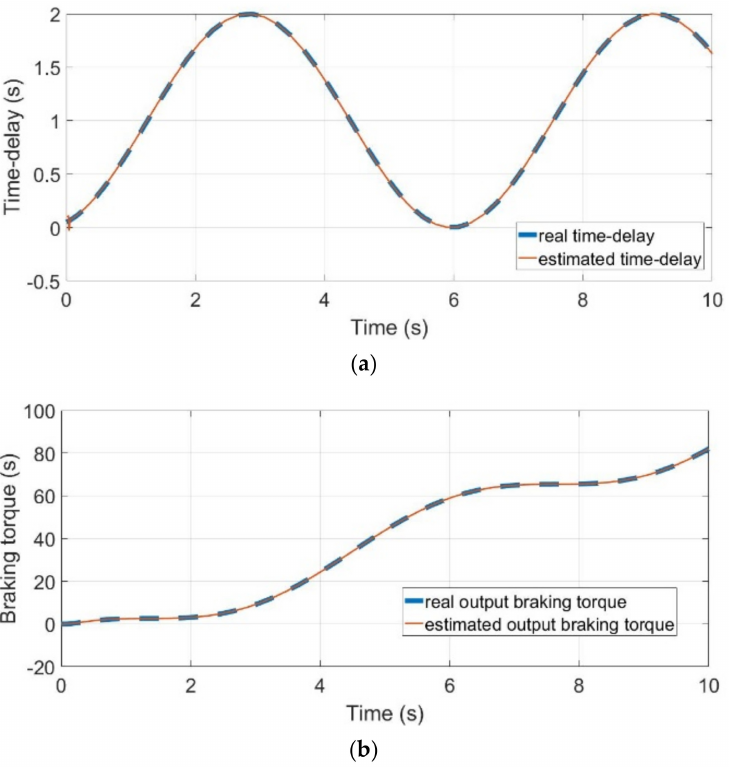
Figure 8. ( a ) Time − delay estimation when the input time-delay is a sinusoidal signal. ( b ) Braking torque estimation when the input time-delay is a sinusoidal signal.